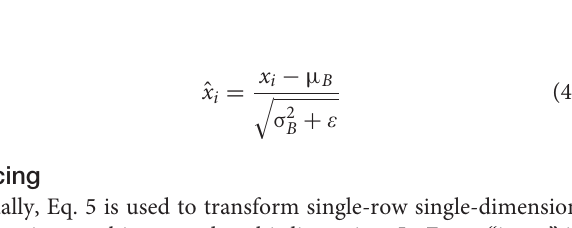
FIGURE 3 | Wearable device appearance and internal